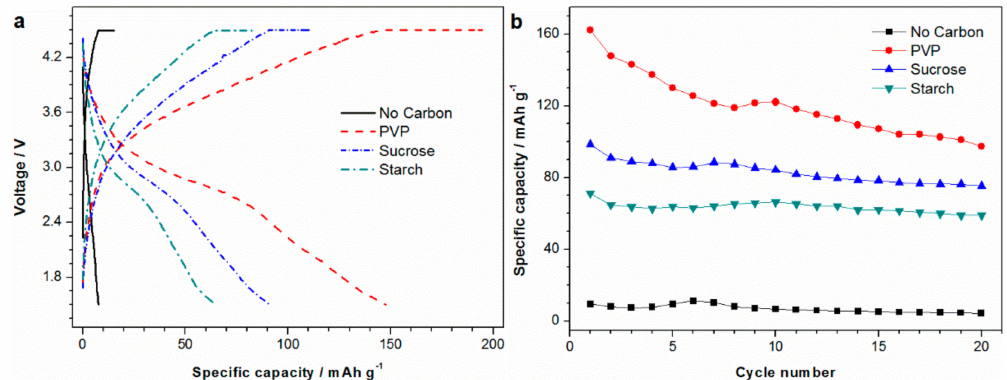
Figure 6. ( a ) Charge / discharge curves and ( b ) cycle performance of LiMnBO 3 prepared by ball-milling the raw materials with various carbon additives in ethanol.